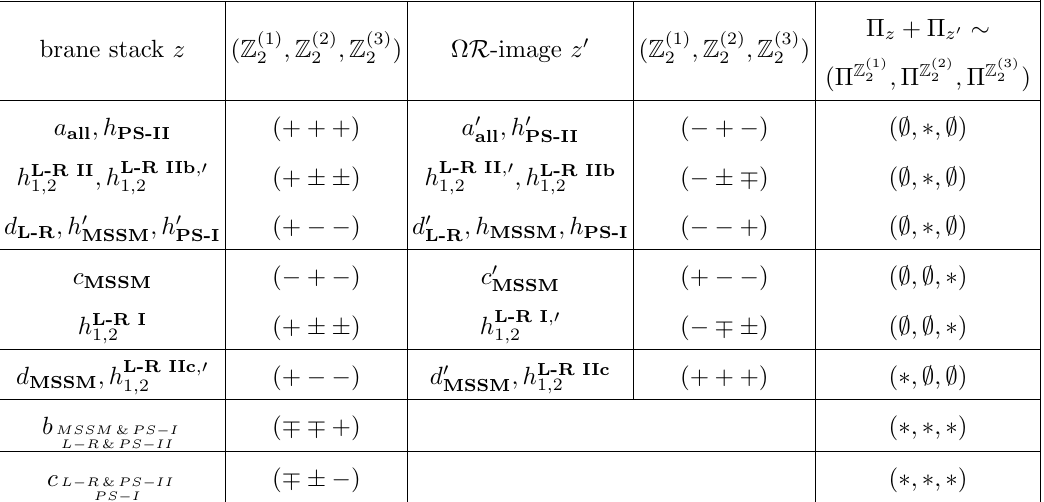
+ (cid:5) = 1 ((cid:5) bulk a 0 2 all all